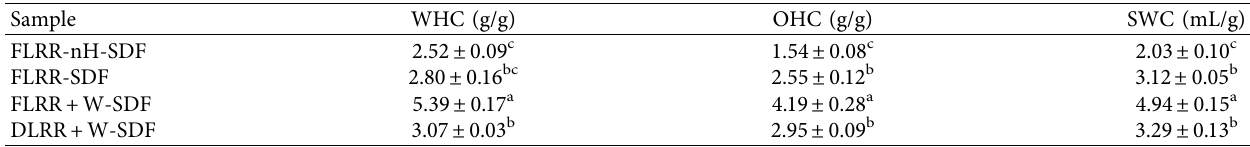
Table 2: Water-holding, oil-holding, and swelling capacities of FLRR-nH-SDF, FLRR-SDF, FLRR +W-SDF, and DLRR+W-SDF samples from LRRs.